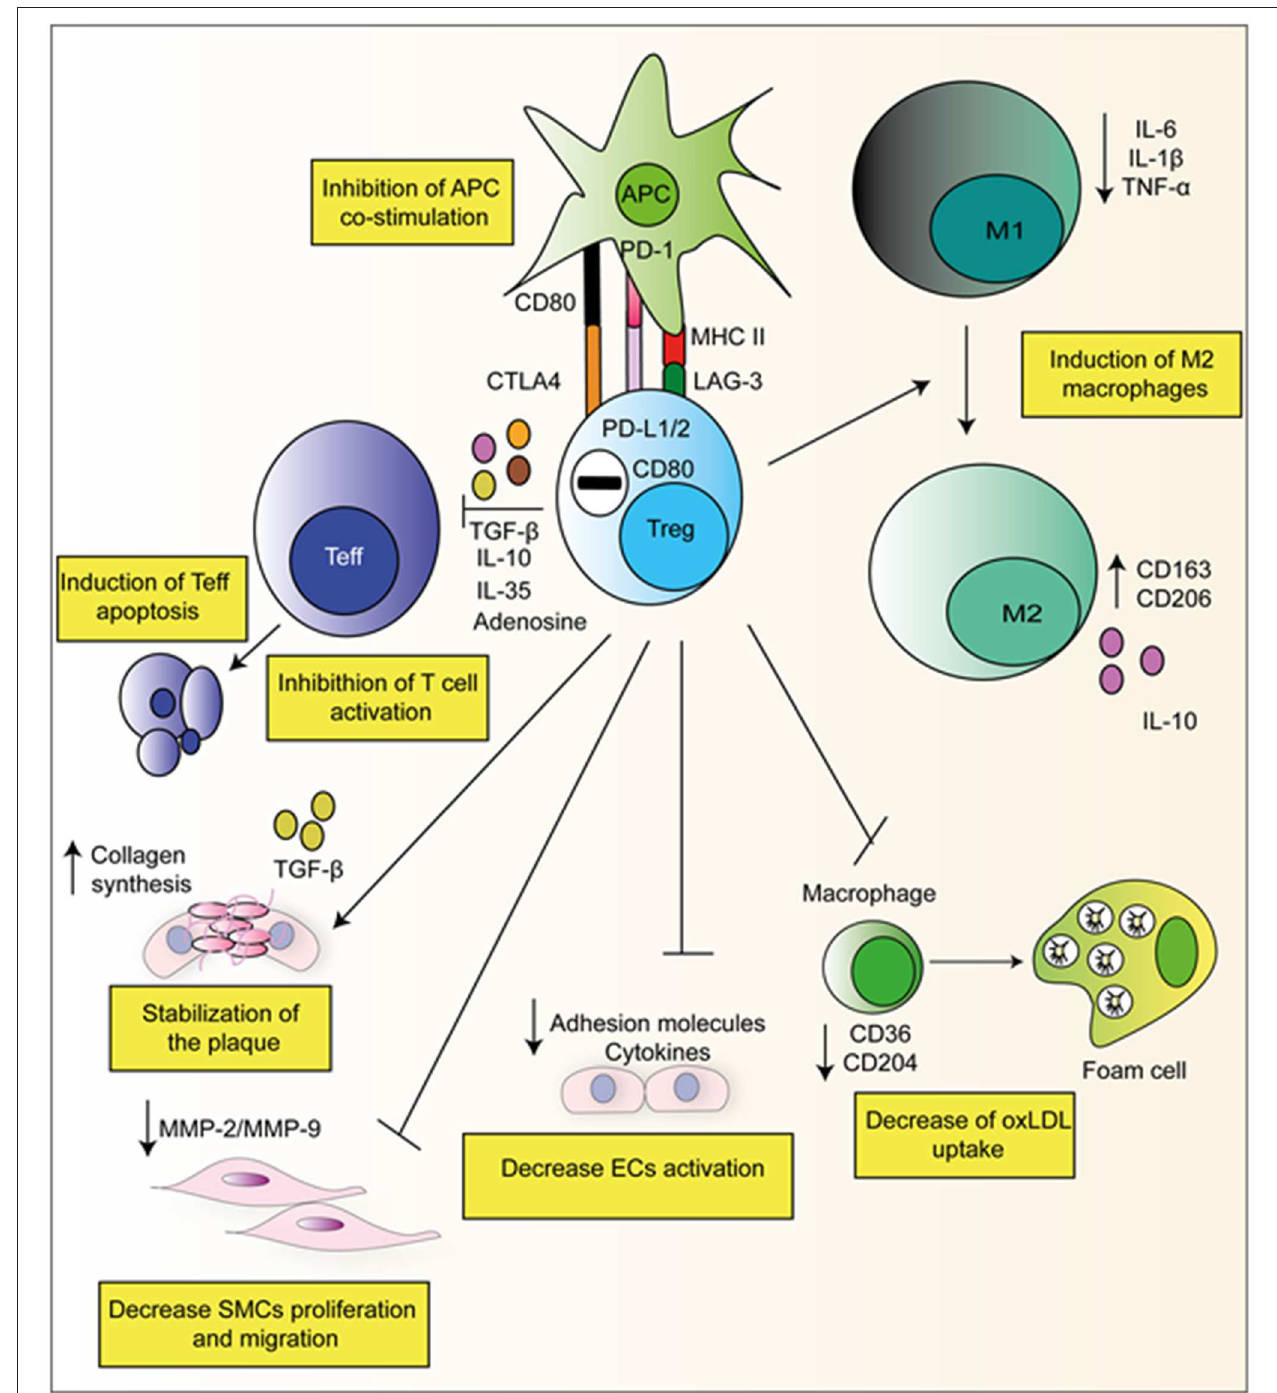
FIGURE 2 | Suppressive mechanisms of Tregs in atherosclerosis. Tregs can directly produce suppressive cytokines and degradative enzymes such as perforin and granzyme that leads to apoptosis. Furthermore, Tregs have been observed to have direct effects on APC’s via interaction with via CTLA-4, PD-L1/2, and LAG-3. They can also skew monocyte class switching, encouraging anti-inflammatory M2 macrophages formation which produced collagen and stabilizes the plaque. They can also decrease foam cell formation via the down-regulation of CD36 and CD204.